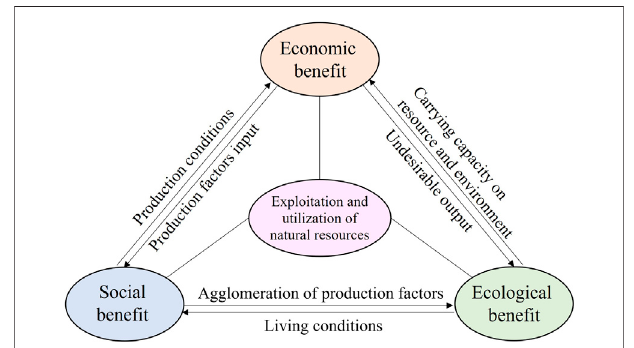
FIGURE 1 | Interaction among economic, social, and ecological bene fi